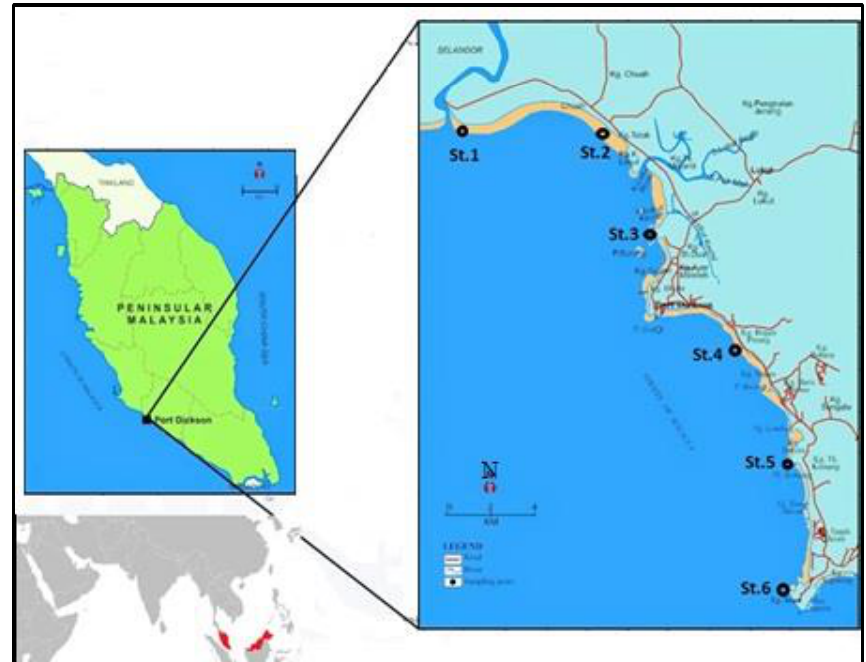
Figure 1. Study area located along the Port Dickson coast, Malaysia, stretching from Sungai Sepang in the north to Tanjung Tuan in the south. Circles indicate the sampling stations.